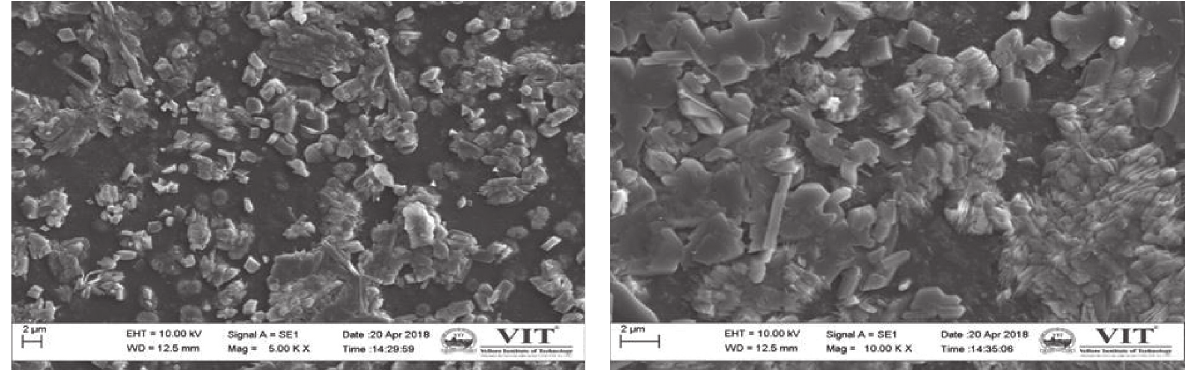
Figure 6: Scanning electron microscopic images of copper nanoparticles synthesized using A. paniculata .